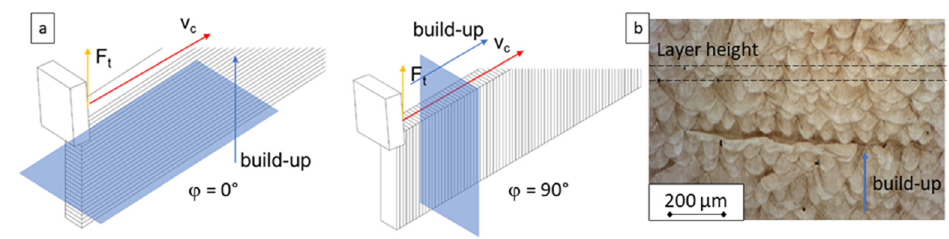
Figure 1. ( a ) Scheme of the built-up orientation angle φ ; ( b ) microstructure of the utilized maraging steel [3].